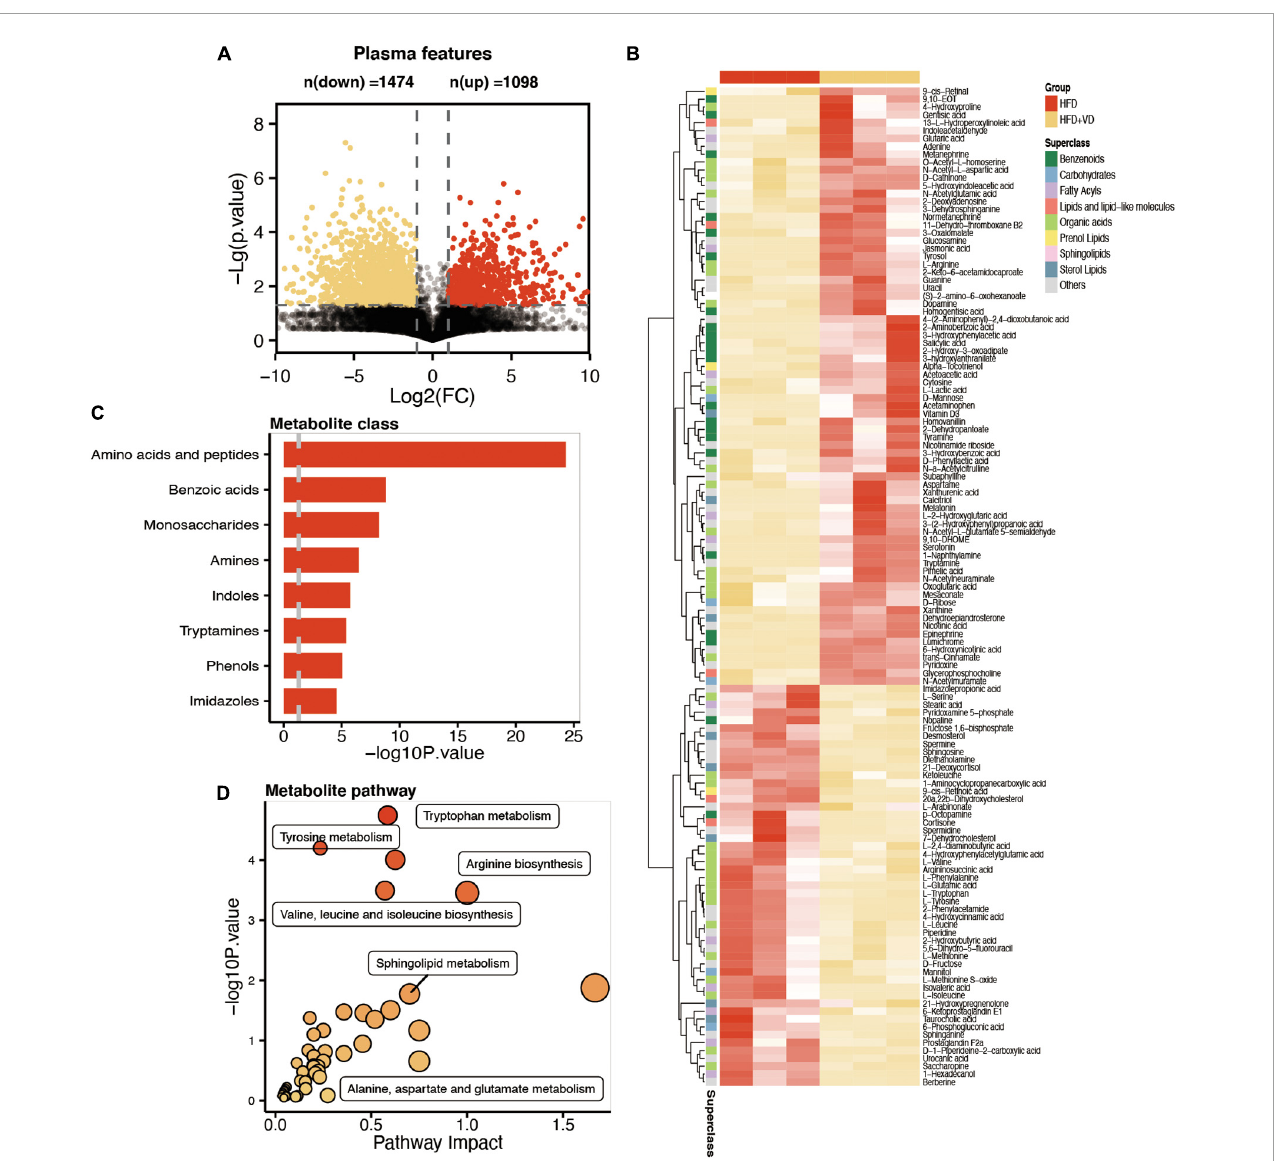
FIGURE5 Comparative metabolomics analysis determines the change in plasma metabolites in high-fat diet (HFD) + VD from HFD. (A) The volcano plot shows the number of dysregulated metabolite features between the two groups. (B) The heatmap shows the annotated changed metabolites in the plasma profile. (C,D) The metabolic set and pathway enrichment based on the different